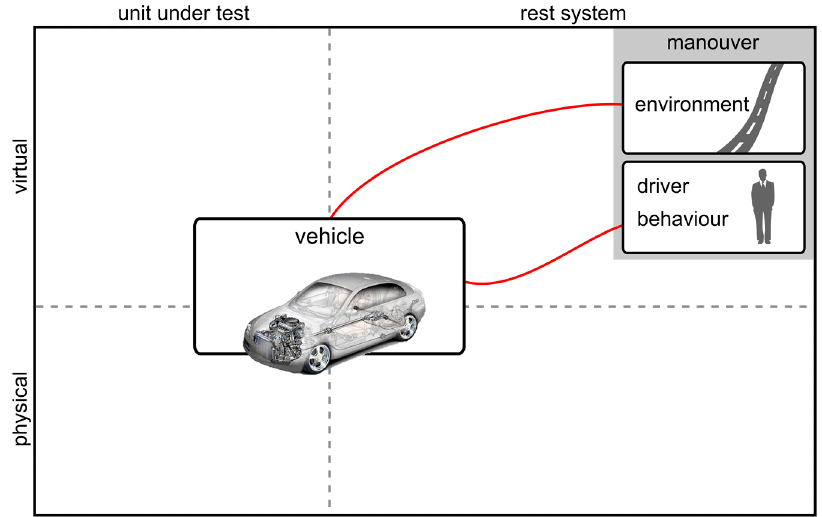
Figure 1. System layout, vehicle-in-the-loop.